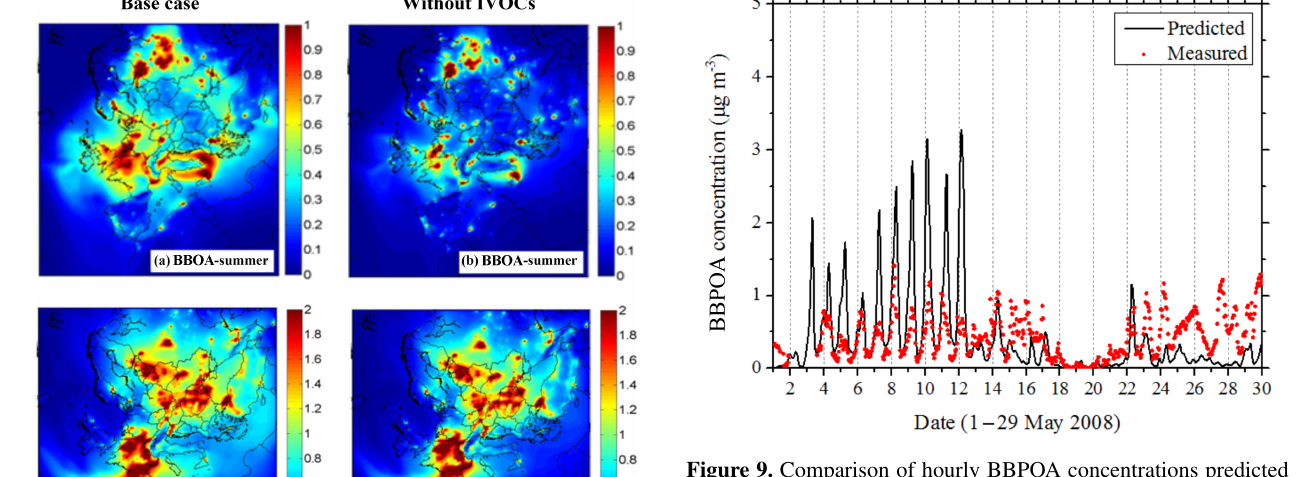
Figure 9. Comparison of hourly BBPOA concentrations predicted by PMCAMx-SR with values estimated by PMF analysis of the AMS data in Cabauw during 1–29 May